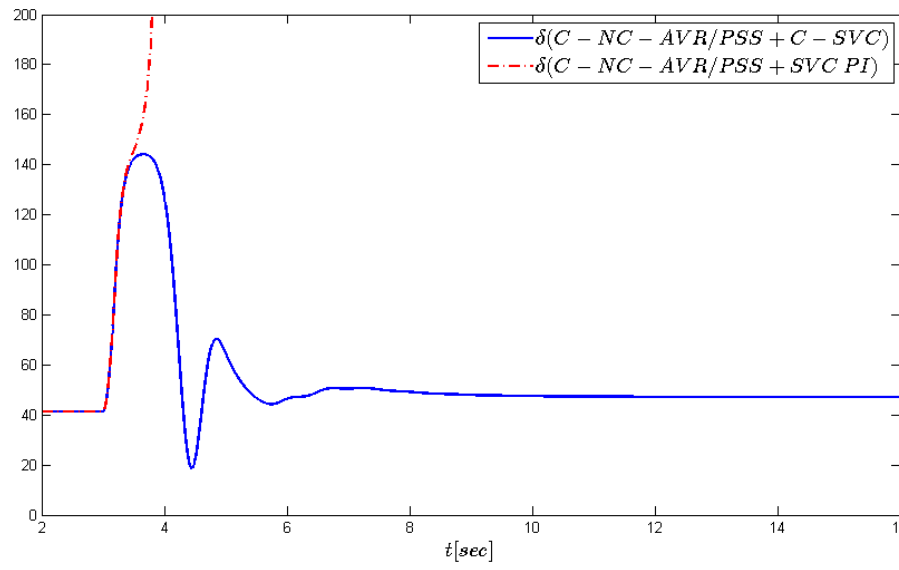
Figure 8. Power angle deviations (in degrees).